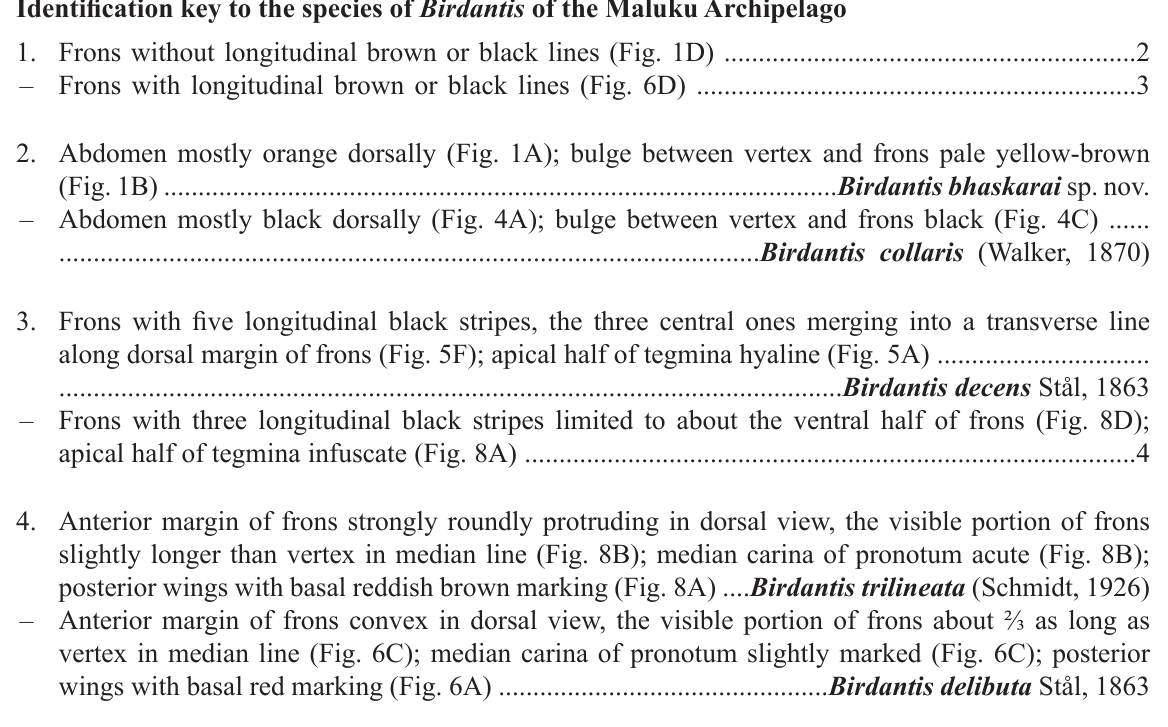
conclusions of the DNA study by Urban & Cryan (2009), which place the genus close to Desudaba Walker, 1858. However, the latter study did not contain any species of the genera Polydictya , Gebenna or Desudaboides , which are putatively considered closely related to Birdantis based on morphological characters. Hence, an accurate tribal placement requires a complete study of the suprageneric relations between the genera of Aphaeninae with the inclusion of more Old World taxa in the molecular analysis and the integration of morphological data (Urban & Cryan